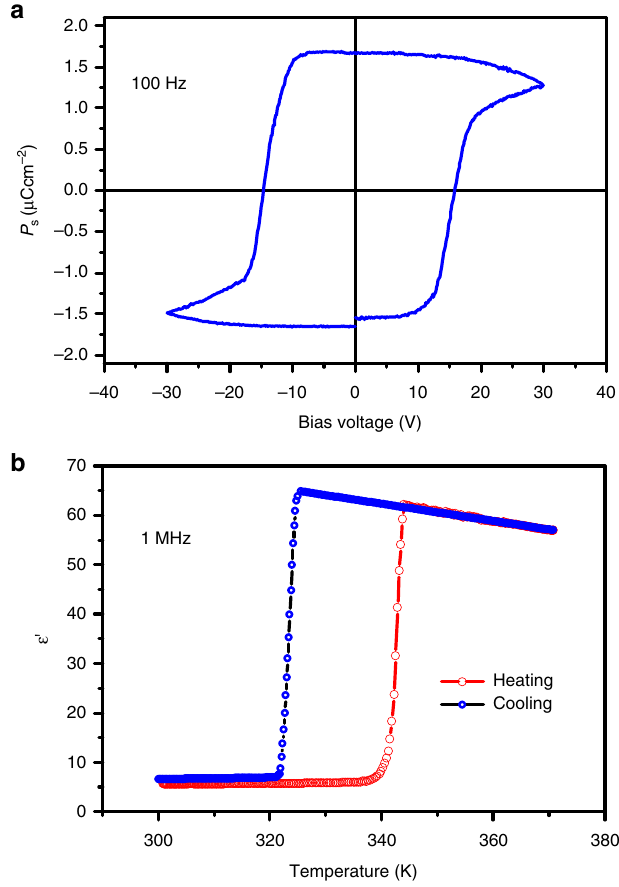
Figure 5 | Polarization reversal and dielectric properties in 1. ( a ) The electric polarization versus electric field ( P–E ) hysteresis loop measured from a film of 150nm in thickness. ( b ) The real part e 0 of the complex dielectric constant ( e 0 ) ( e ¼ e 0 (cid:2) i e 00 ), where e 0 is the real part, and e 00 is the imaginary part) as a function of